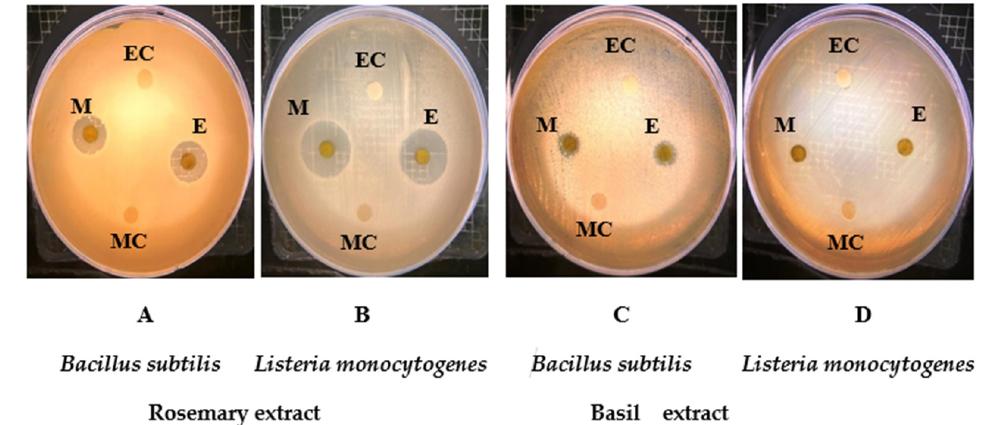
Figure 1. Zone of inhibition for both ethanolic and methanolic extracts of rosemary and basil against B. subtilis ( A and C ) and L. monocytogenes ( B and D ). E: Ethanolic extract of rosemary; M: Methanolic extract of rosemary; EC: Ethanol control; MC: Methanol control. Table 2. Zone of inhibition (mm), MIC and MBC of the of ethanolic and methanolic extracts of rosemary against L. mon- ocytogenes and B. subtilis.